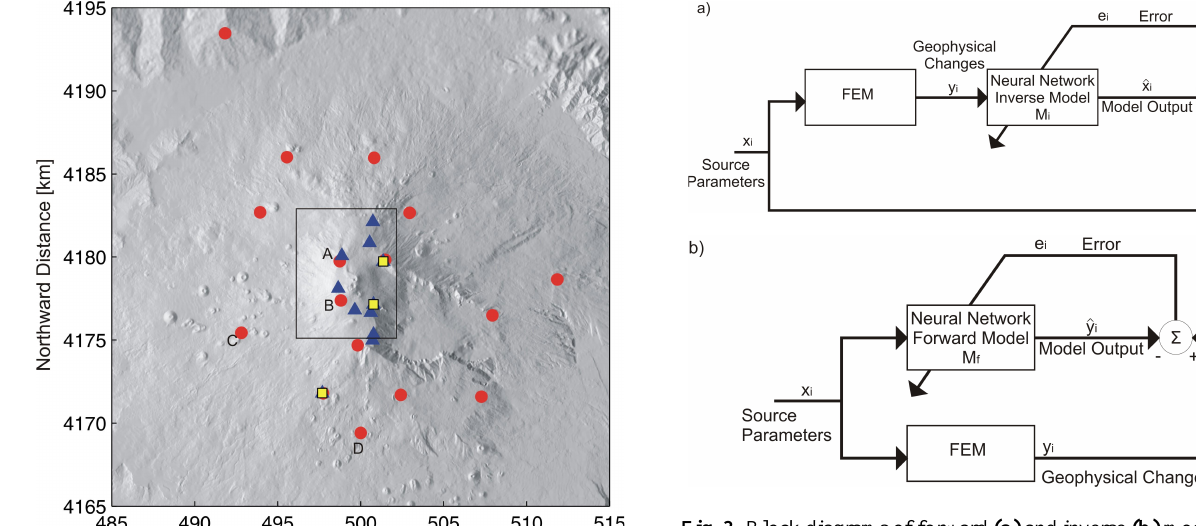
Fig. 3. Block diagrams of forward (a) and inverse (b) model identi-